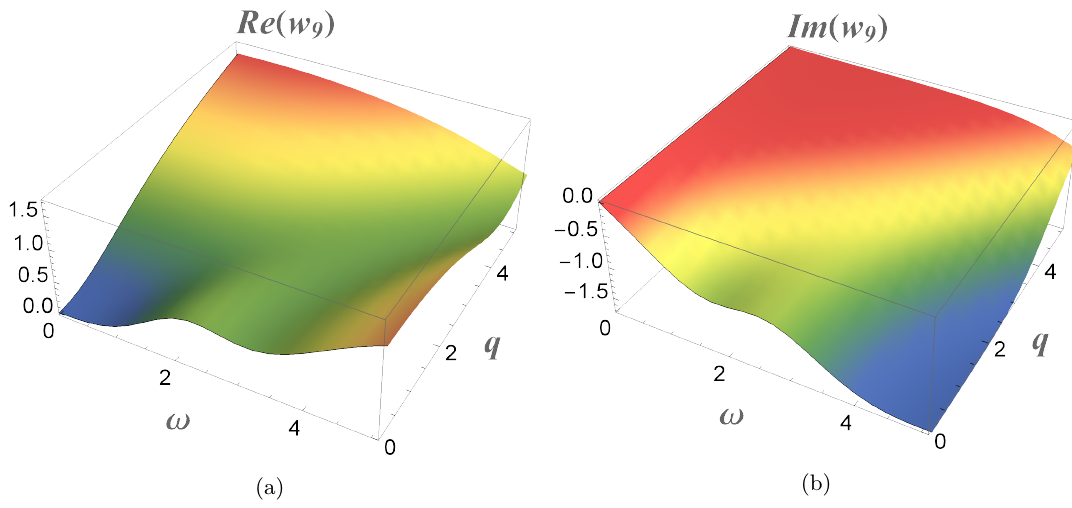
Figure 11 . Plots for ω -, q -dependence of the coefficients (a) Re ( w 9 ( ω, q )) , (b) Im ( w 9 ( ω, q ))